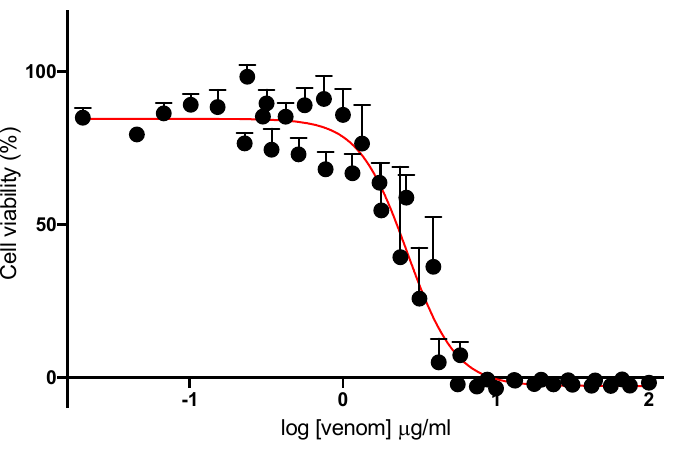
Figure 5. Concentration-dependent venom-induced inhibition of cell viability in L6 cells.